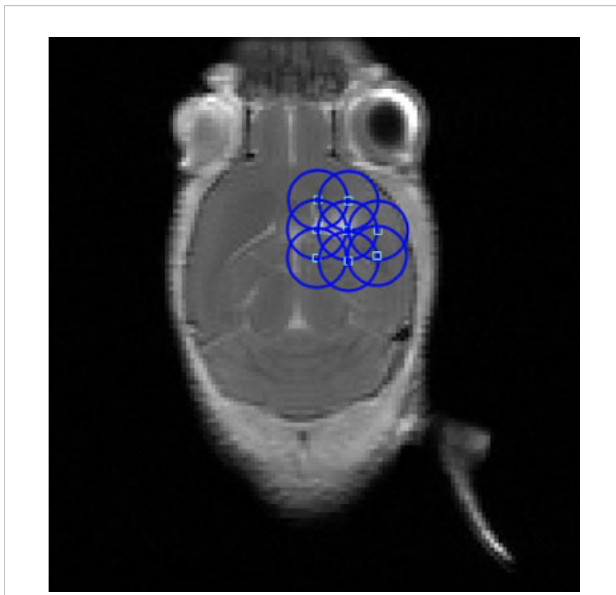
FIGURE 1 Example Focused Ultrasound (FUS) Sonication grid overlaid on an axial, contrast-enhanced T1-weighted magnetic resonance imaging (MRI) of a mouse with an orthotopically-implanted glioblastoma multiforme (GBM) tumor.